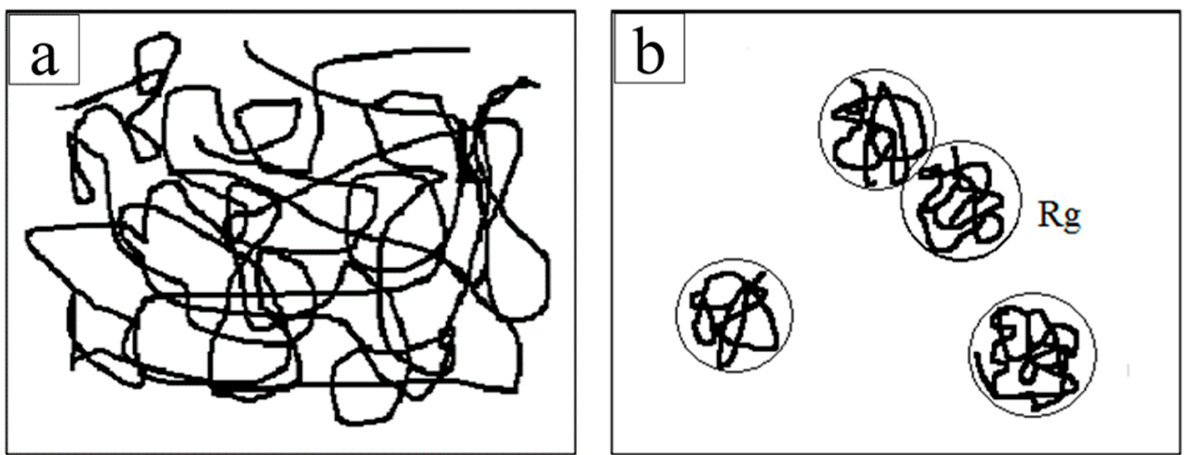
Figure 4. The entangled state of the polymer in the solution: ( a ) polymer solution without metal cation; ( b ) polymer solution with metal cation.